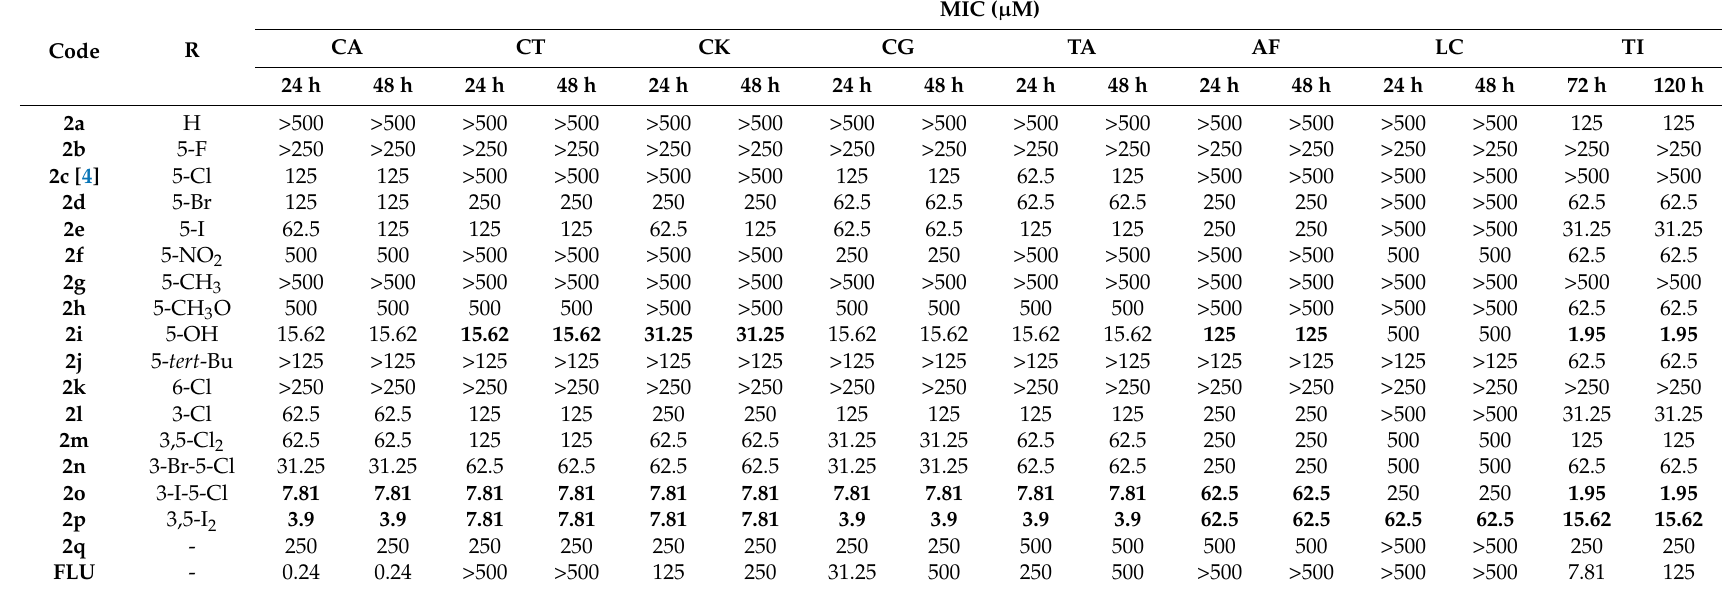
Table 3. Antifungal activity of sulfadiazine derivatives 2